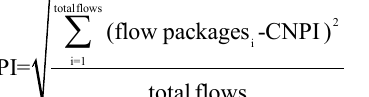
Figure 7. Topographies of VPI for Public Carriages